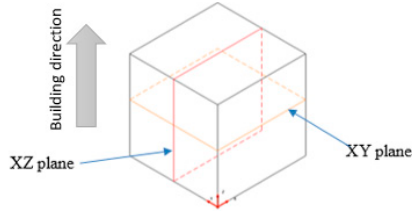
Figure 2. Sectioning planes for optical microscopy.